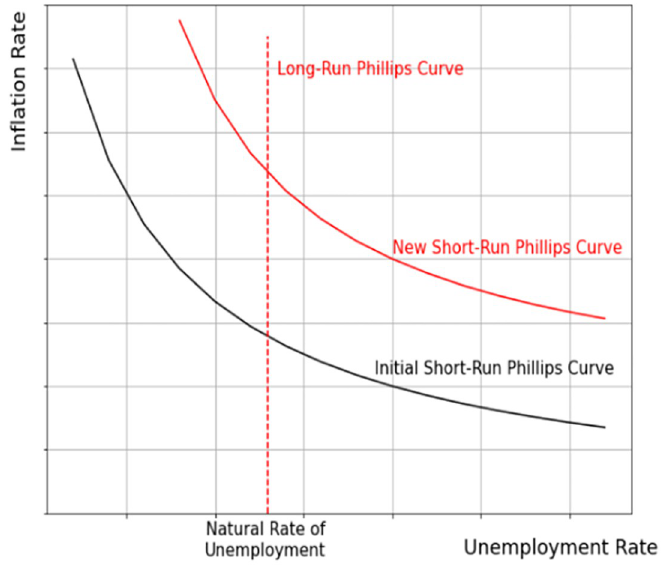
Fig 1. Phillips curve. The long-run and short-run Phillips